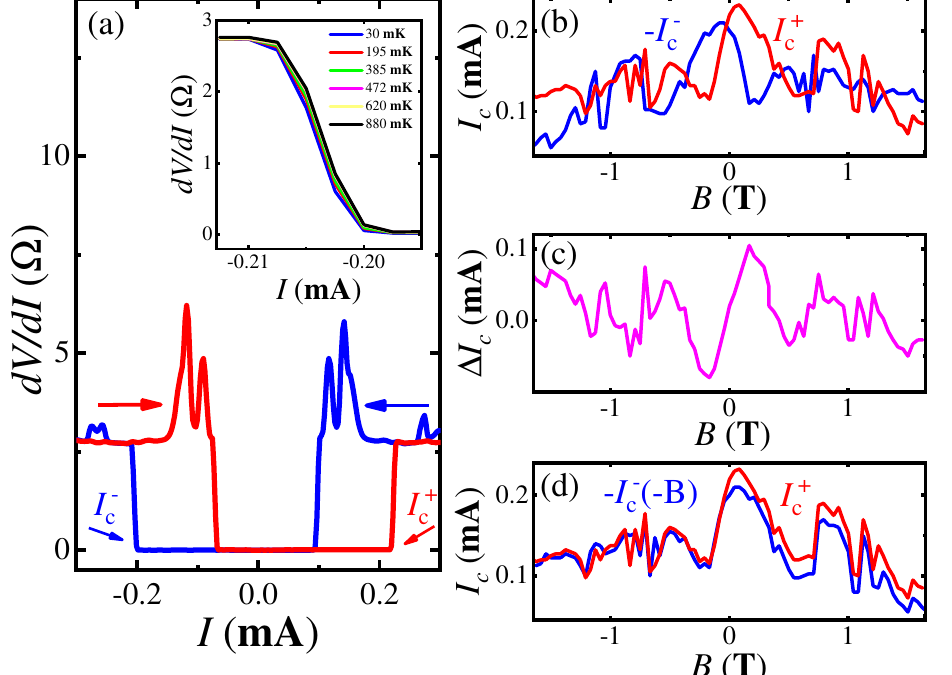
Figure 5. (Color online) Josephson diode effect for a double Nb-NiTe 2 -Nb junction. ( a ) Examples of dV / dI ( V ) curves for two different current sweep directions for 26 mT in-plane magnetic field. Apart from standard hysteresis for superconducting–resistive and resistive–superconducting transitions, non-reciprocal response is seen even for the same superconducting–resistive part of the curves, as depicted by I + c = 0.22 mA and I − c = − 0.20 mA values. The inset shows the temperature